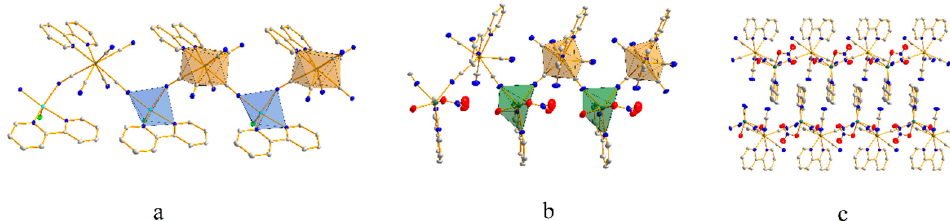
Figure 1. Inorganic coordination chains running in the direction of [100] are formed as a result of cyanido bridging interactions between two metal atoms, W(V) and Zn ( 1 , ( a )), as well as W(V) and Cd ( 2 , ( b )). The yellow color indicates the coordination polyhedra [W(CN) 6 (bpy)] − (square antiprism), while the blue and green colors indicate the coordination polyhedra around Zn 2+ (octahedron) and Cd 2+ (distorted trigonal prism) cations, respectively. ( c ) view in direction of [010] showing the spatial packing of structure 2 . Interactions of the π – π type are visible. All non-hydrogen atoms are represented with a 30% thermal ellipsoid probability. Hydrogen atoms were omitted for clarity.